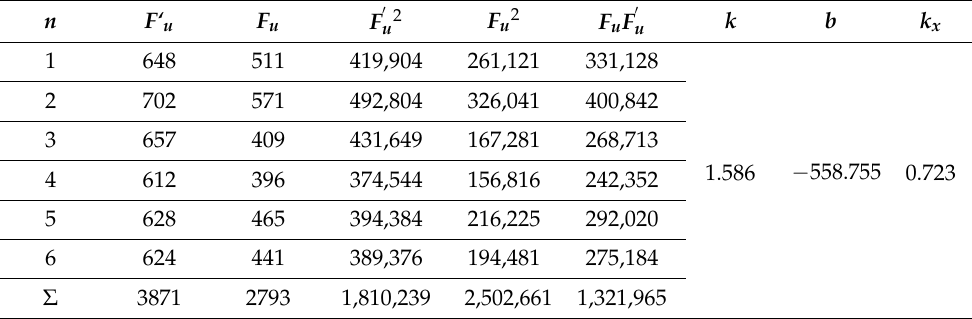
Table 4. Results of calculating the functional dependence for ordinary bored